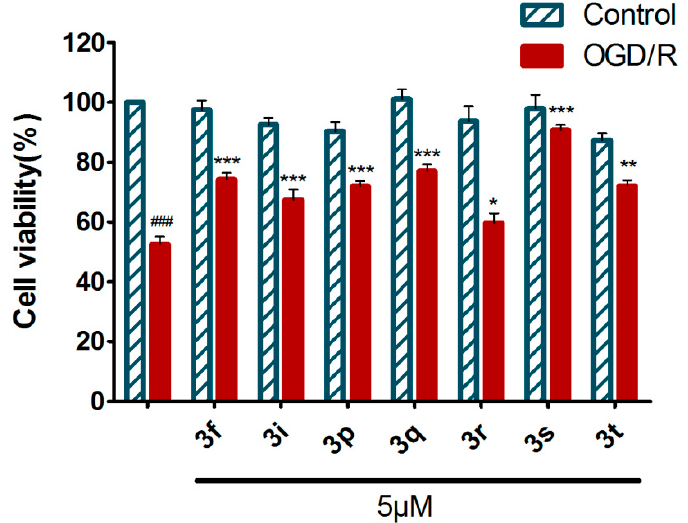
Figure 4. The effect of derivatives 3p–t on the cell viability of human neuronal SH-SY5Y cells: The cells were pretreated with different concentrations of derivatives 3p–t for 24 h, then exposed to OGD/R for 5.5 h, and then reoxygenated for 4 h further. All data are presented as means ± SD (n = 3). ### p < 0.001 vs. control group, * p < 0.05, ** p < 0.01 *** p < 0.001 vs. OGD/R group.